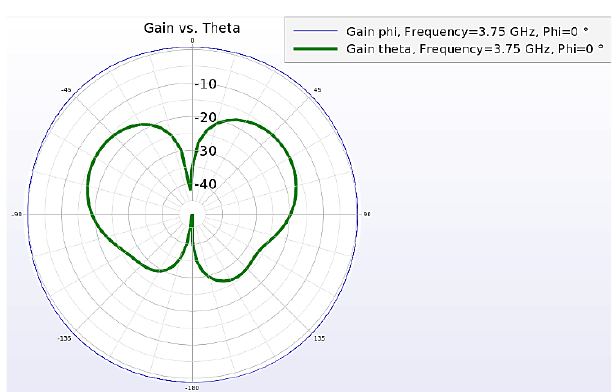
FIGURE 7. Simulated Gain Plot for 3.75 GHz